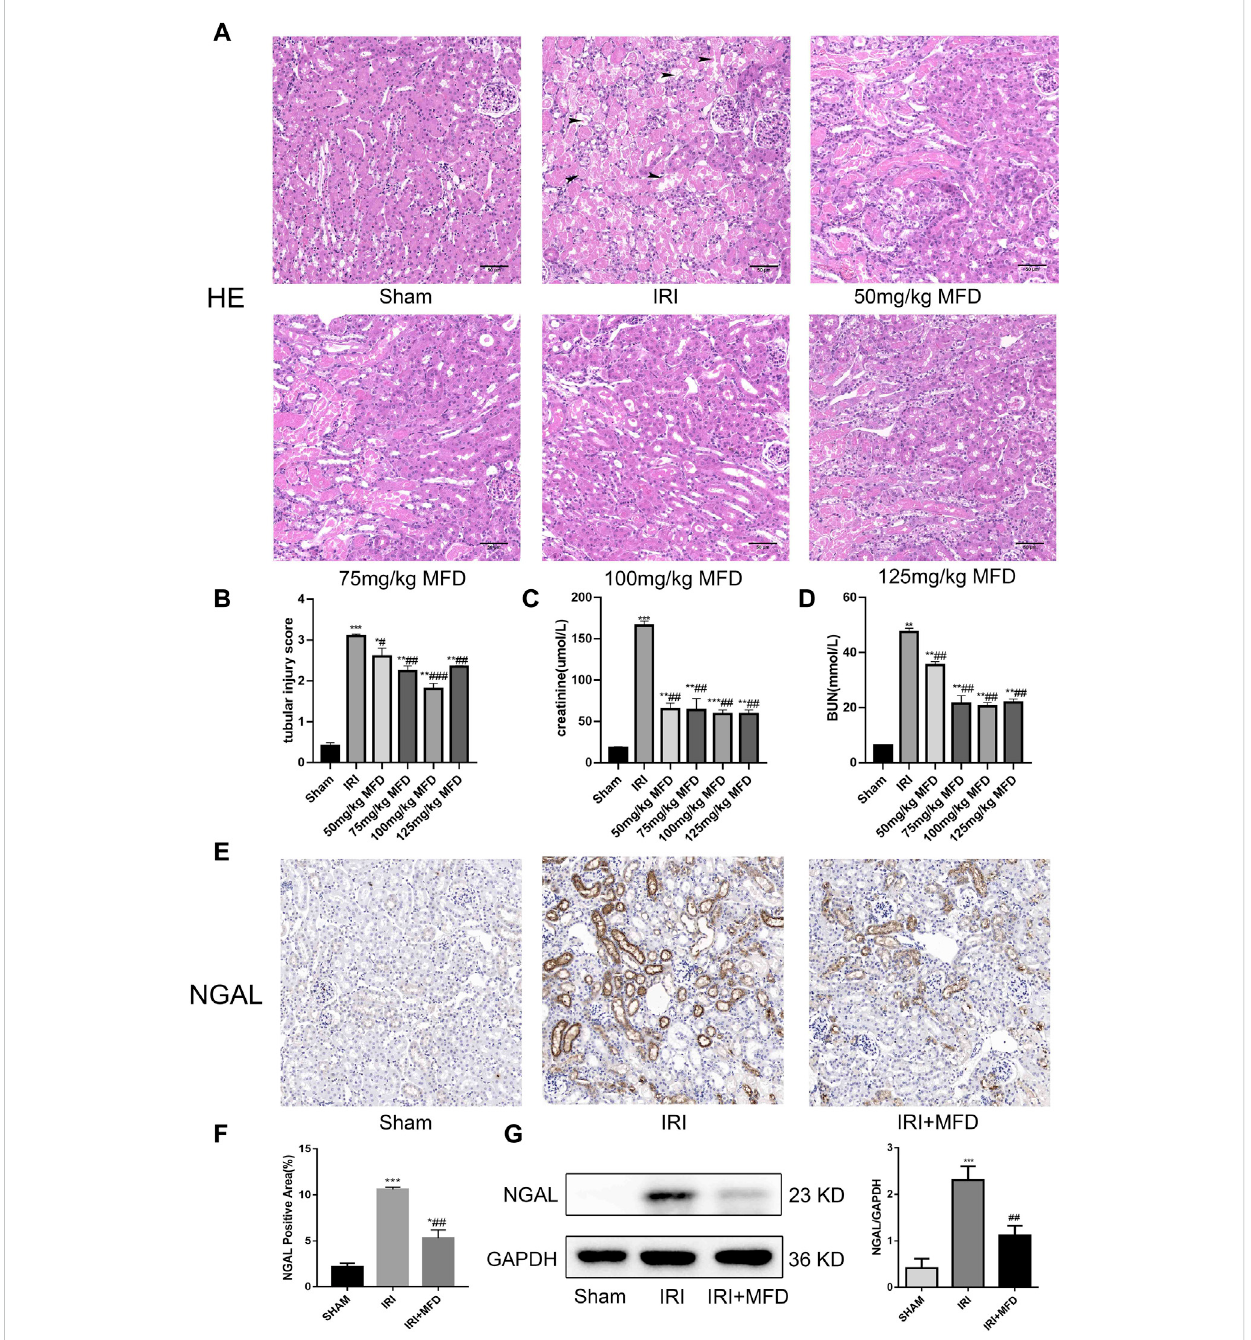
Mefunidone ameliorated IRI-induced AKI (A) HE staining showed protective effect of mefunidone at various doses of 50 mg/kg, 75 mg/kg, 100 mg/kg, 125 mg/kg on renal tubular injury on day 2 after IRI modeling (×200). arrows for renal tubular damage. (B) The tubular injury scores of HE staining for kidney damage. (C) Serum creatinine (SCr) levels of mefunidone at various doses of 50 mg/kg, 75 mg/kg, 100 mg/kg, 125 mg/kg on renal tubular injury on day 2 after IRI modeling. (D) Blood urea nitrogen (BUN) levels of mefunidone at various doses of 50 mg/kg, 75 mg/kg, 100 mg/kg, 125 mg/kg on renal tubular injury on day 2 after IRI modeling. (E,F) Histological images of immunohistochemical staining with NGAL and evaluation of NGAL positive area in each group on day 2 after IRI modeling (×200). Mefunidone: 100 mg/kg. (G) Western blot analysis and quantitative data of NGAL in each group on day 2 after IRI modeling. Mefunidone: 100 mg/kg. Data represent mean ± SEM ( n = 3 – 5). * p < 0.05, vs. Sham group; ** p < 0.01, vs. Sham group; *** p < 0.001, vs. Sham group; # p < 0.05, vs. IRI group; ## p < 0.01, vs. IRI group; ### p < 0.001, vs. IRI